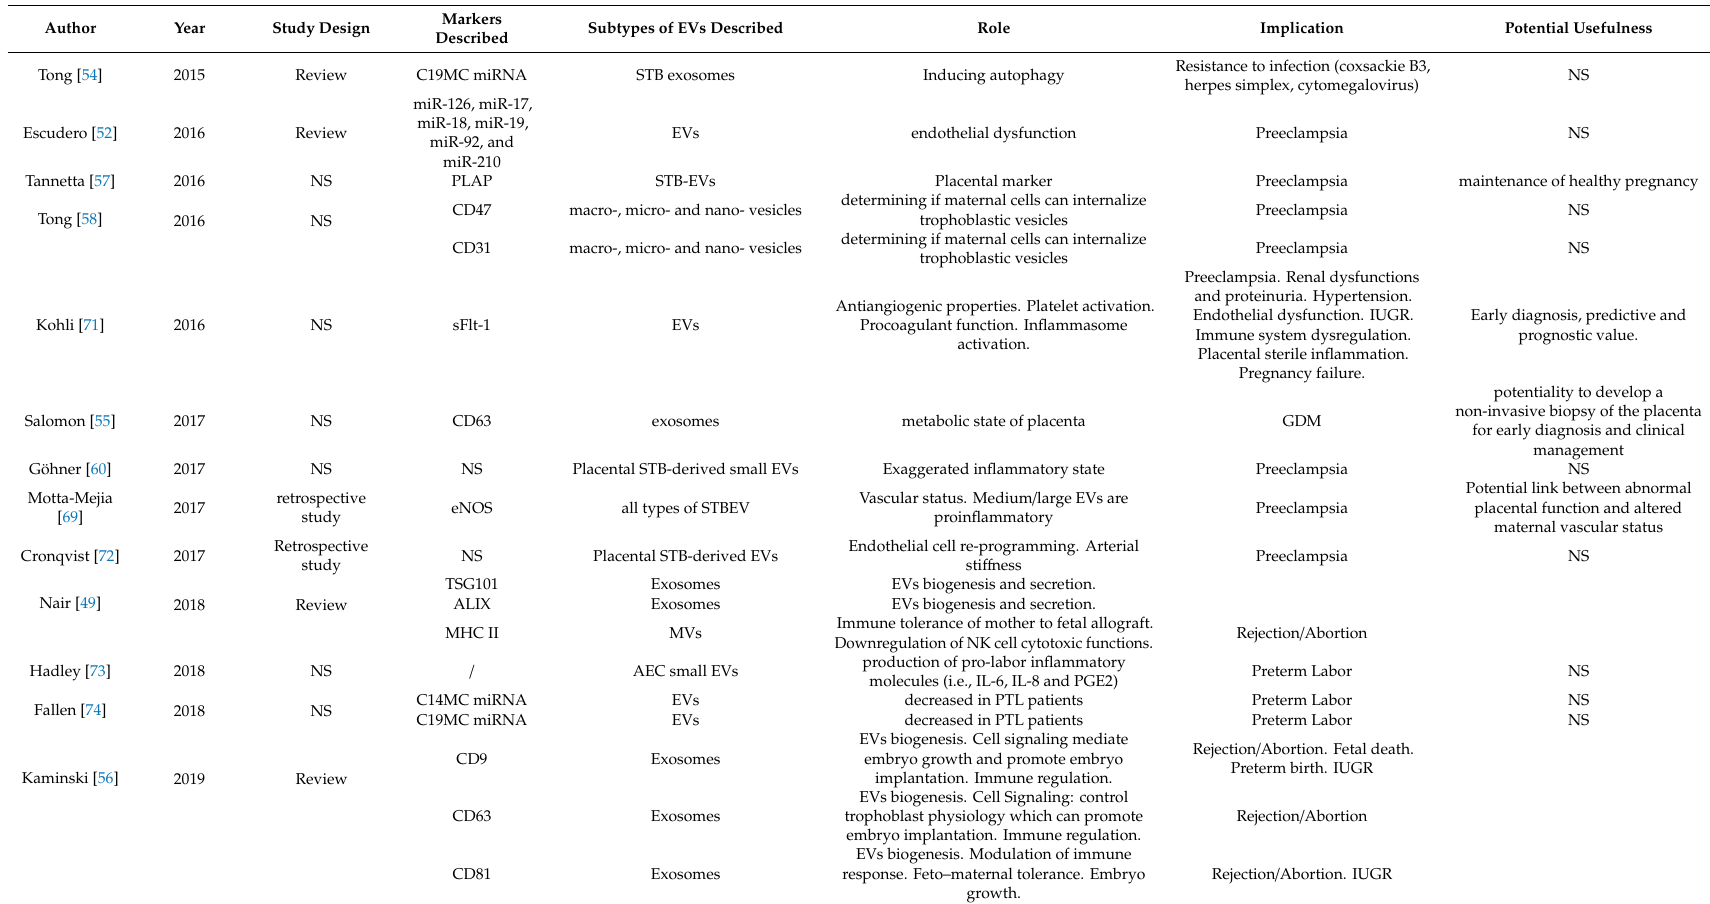
Table 1. General characteristics of the studies included in the